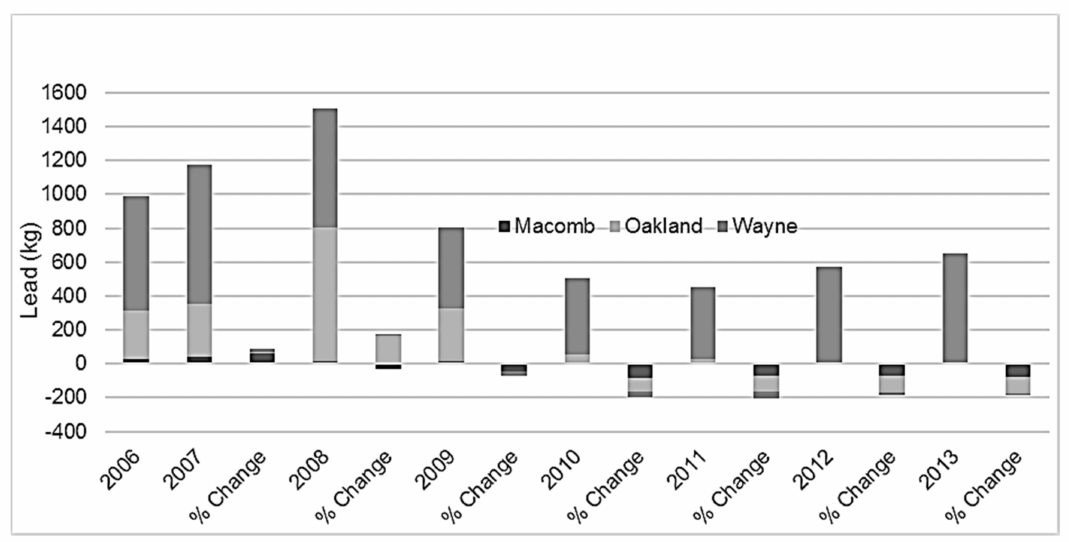
Figure 3. Total reported lead emissions and percent change by county using 2006 as the baseline, Detroit Metropolitan Area,